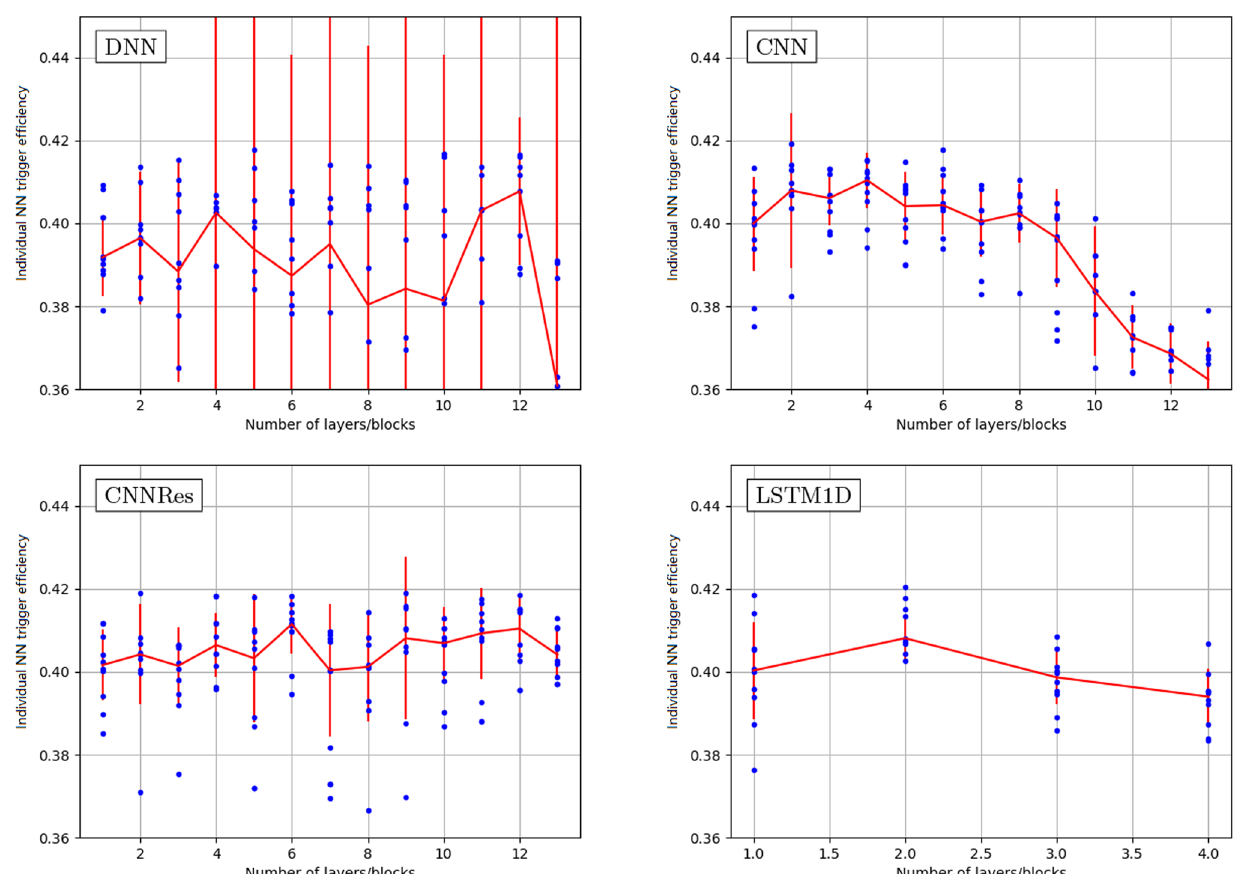
Fig. 3 Individual trigger efficiencies (blue dots) for the channel Dch at 5 . 5 GeV/ c for four of the seven NN types with varying depth parameters as well as the median with standard deviation (red makers and bars) from varying the weight seeds Fig. 4 Normalised triggering performance ˆ (cid:9) as function of the used layers/blocks in the seven network types, combined for the three channels Etac , Dch and Lamc at 5 . 5 GeV/